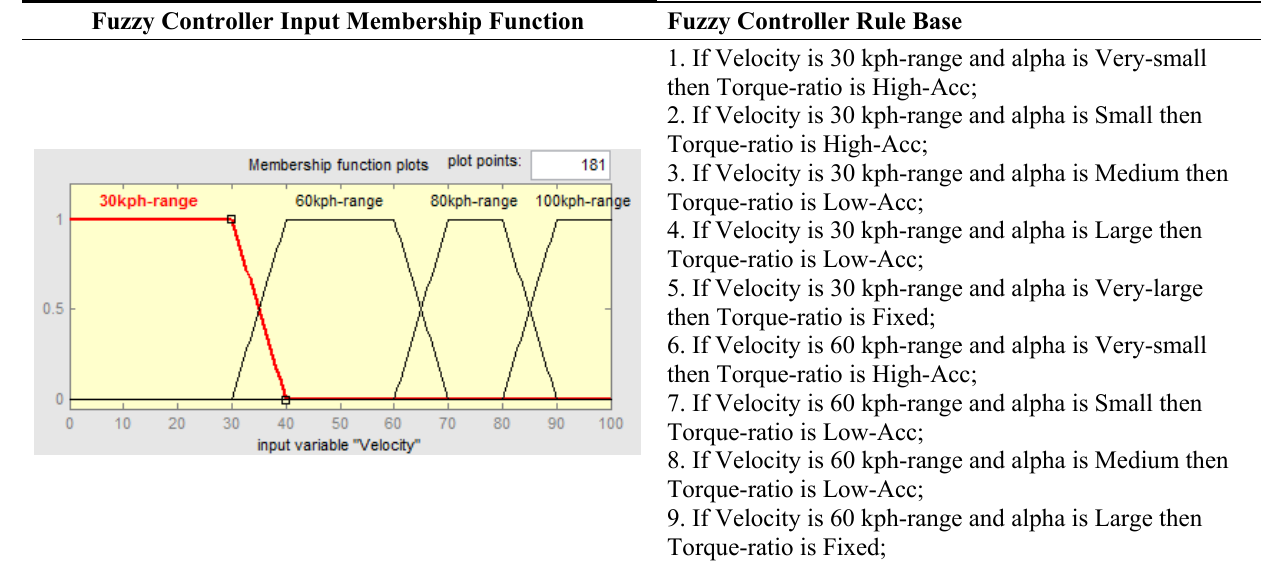
Table 3. Torque distribution strategy that reflects driver’s acceleration